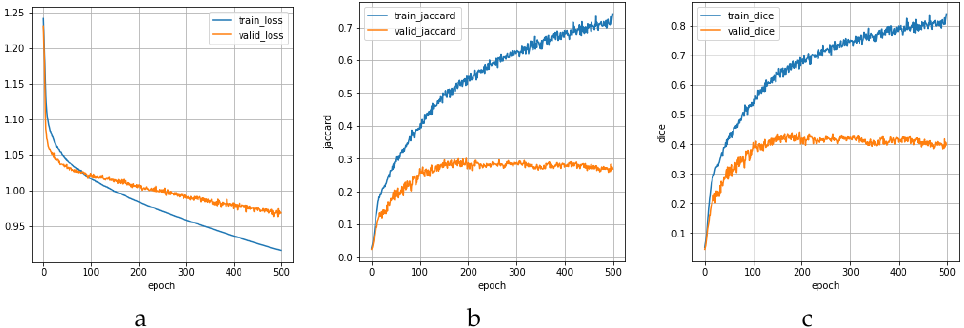
Figure 11. Training curves of the U-Net (( a ) is the loss function, ( b ) is the Jaccard coefficient, ( c ) is the Dice coefficient).